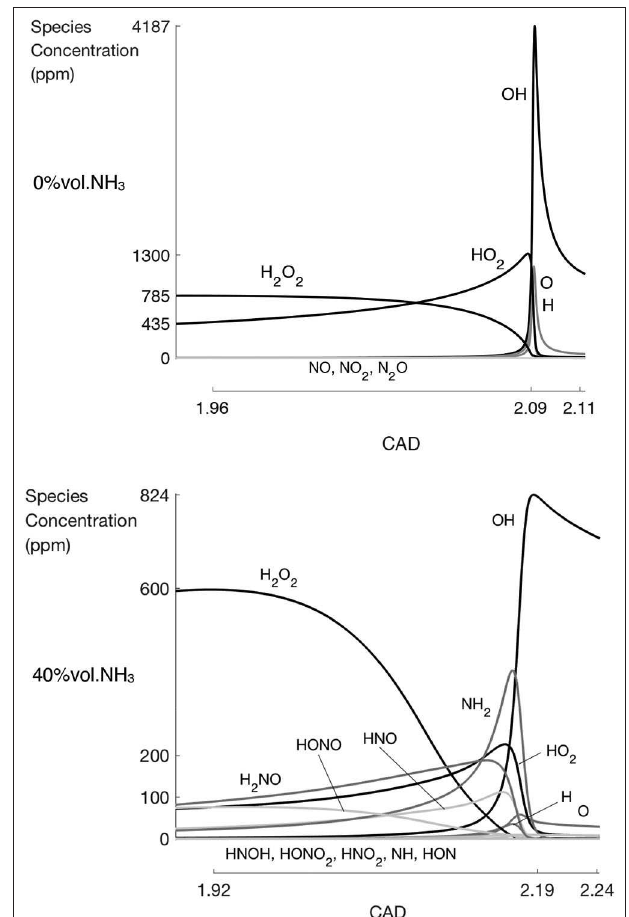
FIGURE 11 | Intermediate species evolution for neat hydrogen (above) and for 40%vol. ammonia content (below). Without ammonia, a pool of H 2 O 2 and HO 2 is formed during the initiation phase, which is eventually consumed for the OH production. With ammonia, a lower OH peak is observed, together with a significant amount of non-reactive intermediate species being formed. Obtained using the HCCI single zone model developed in Pochet et al. (2017a) together with the mechanism from Mathieu and Petersen